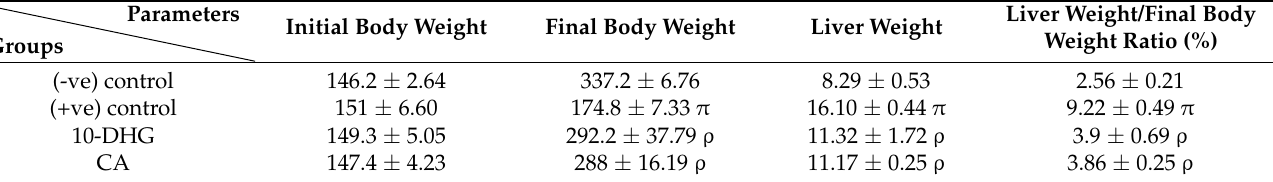
Table 2. Effect of caffeic acid and 10-dehydrogengerdione on body weight and liver weight.